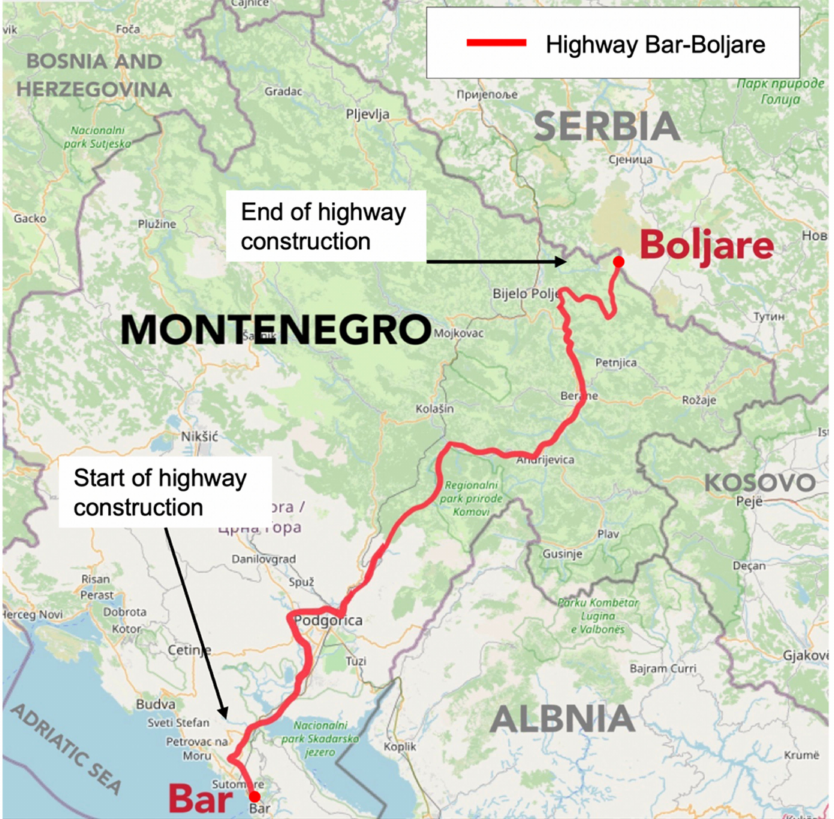
Figure 1. Map depicting the CBI project in Montenegro. Note. Red colored line show the Montenegrin highway construction project conducted by Chinese sojourners. As the project developed, Chinese workers were relocated farther away from the local